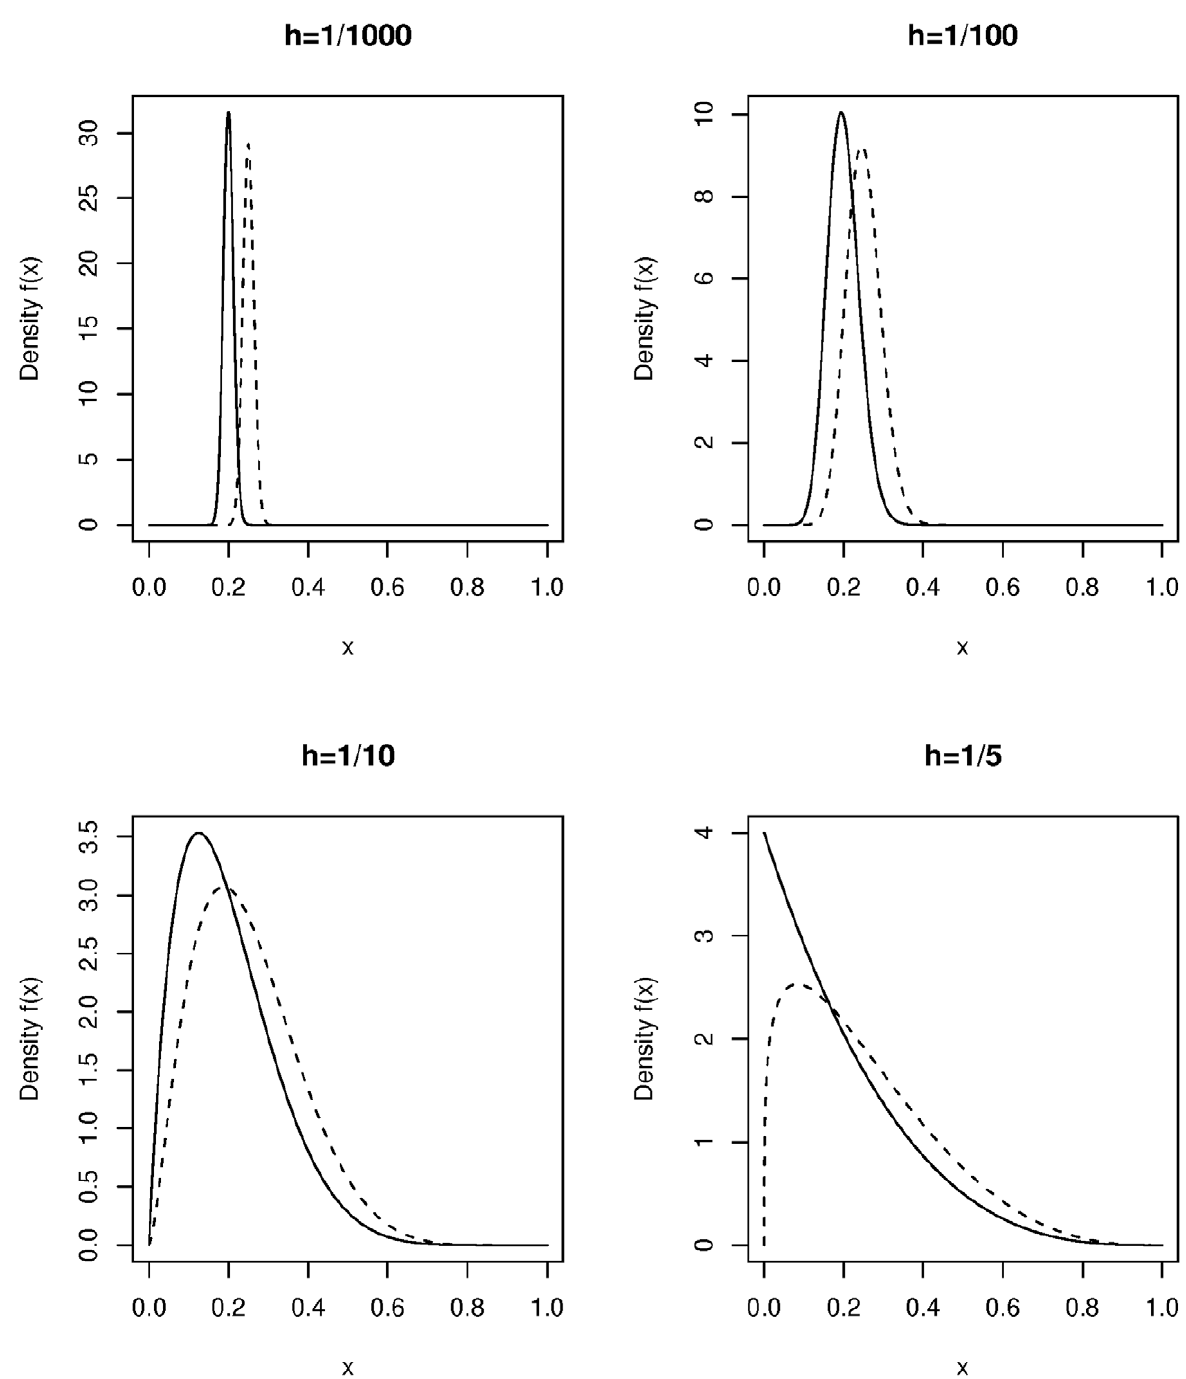
Figure 1. Plot of the density function of beta distributions parameterized by mean a and heterogeneity factor h . On each subplot the density is shown for two choices of a namely a =0.2 (solid line) and a =0.25 (dotted